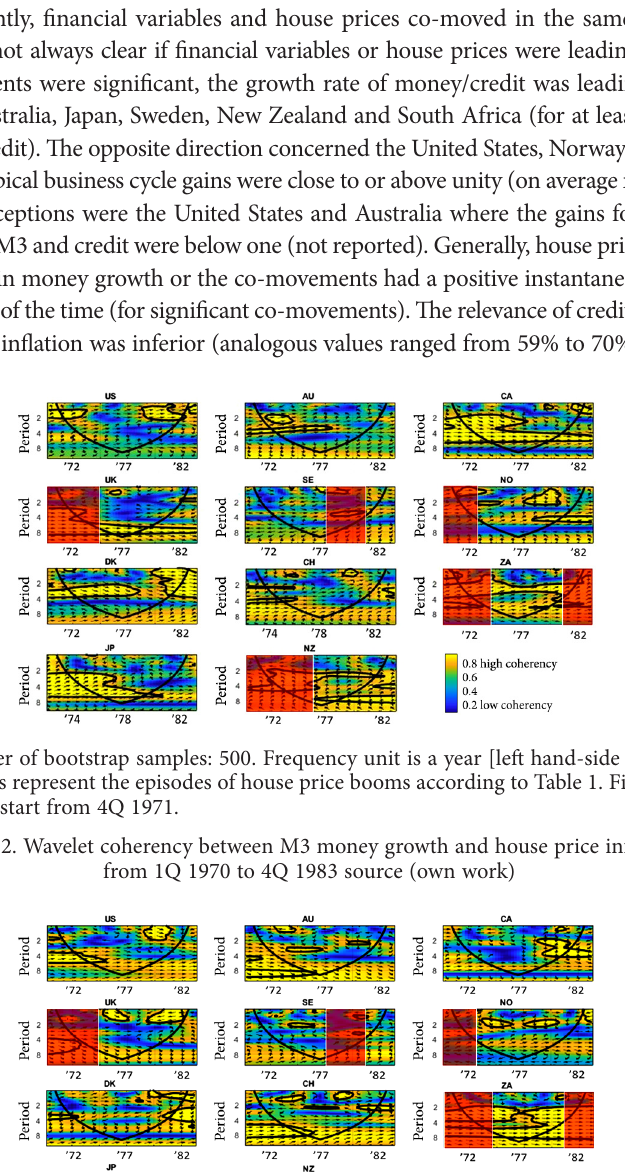
Figure 3. Wavelet coherency between bank credit growth and house price inflation